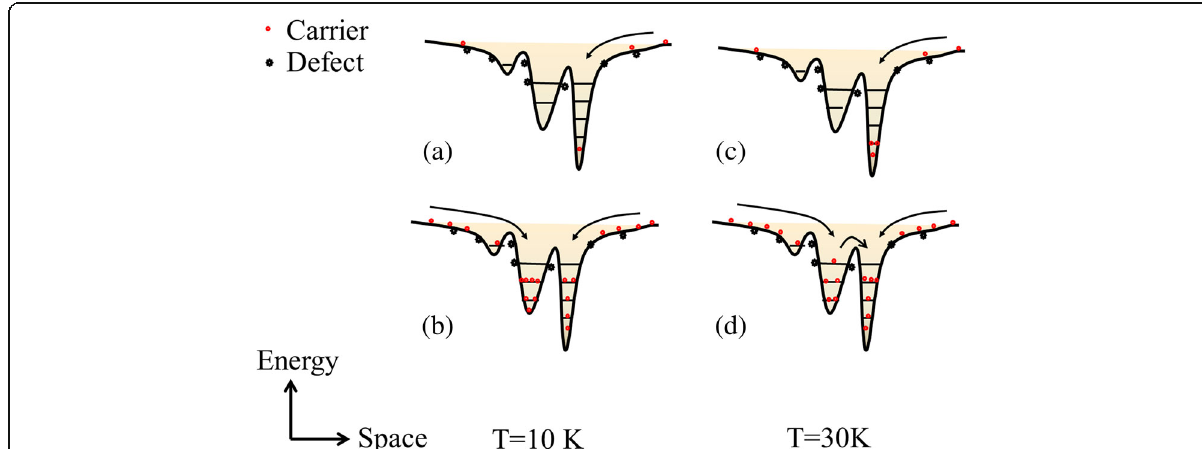
Fig. 6 Schematic diagrams indicating the possible mechanism of the anomalous variation of the PL peak energy vs. T curves with different excitation powers. The carrier distributions at lower T (10 K) are shown in ( a ) and ( b ) for P = 5 mW and 40 mW, respectively. The carrier distributions at higher T (30 K) are shown in ( c ) and ( d ) for P = 5 and 40 mW, respectively